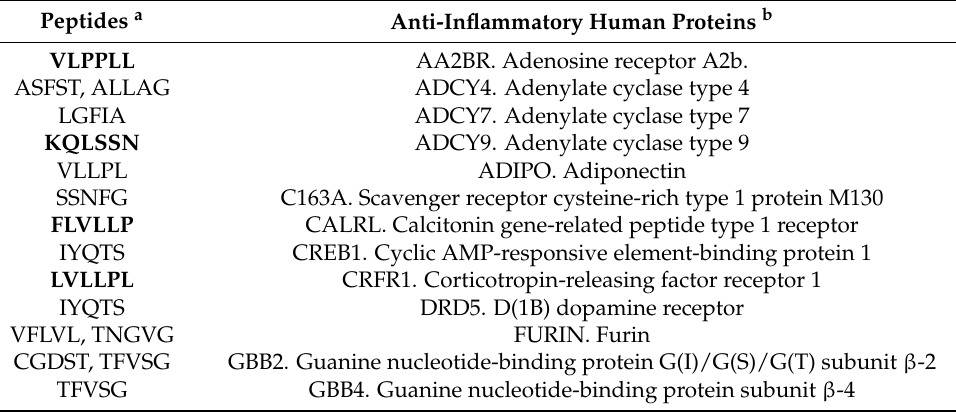
Table 2. Peptide sharing between SARS-CoV-2 spike gp and anti-inflammatory human